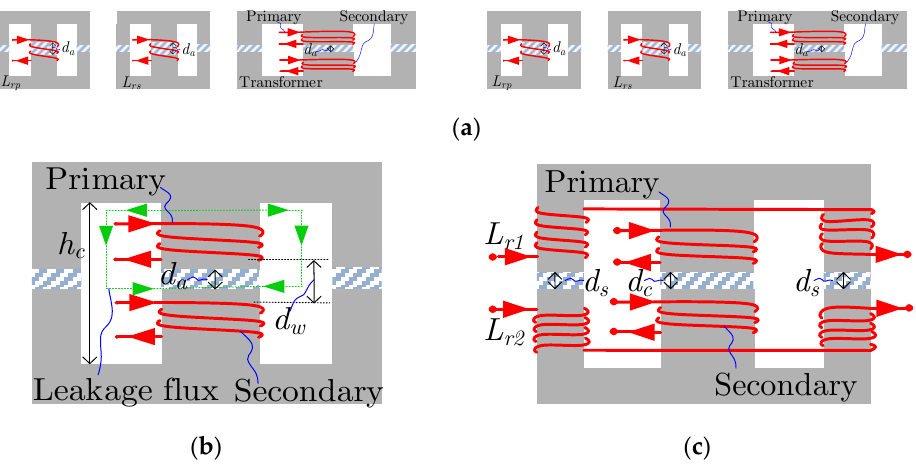
Figure 2. Magnetic design for a CLLC resonant converter: ( a ) Detached magnetic cores; ( b ) conven- tional integrated magnetic structure; ( c ) proposed integrated magnetic structure.